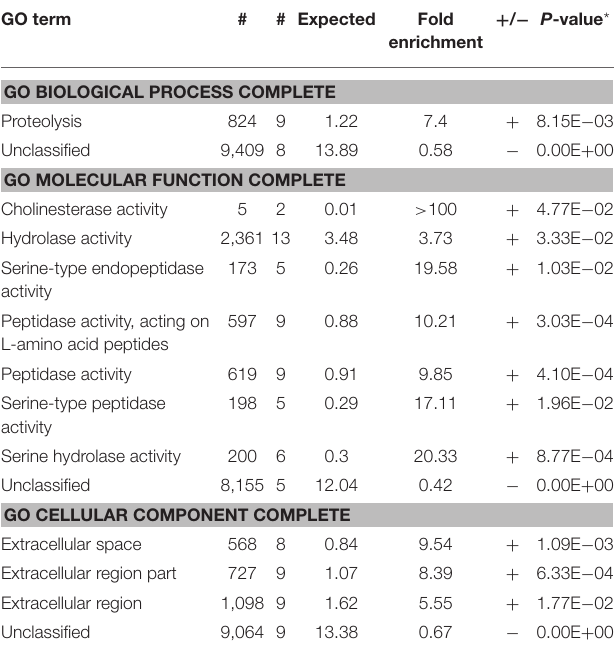
TABLE 1 | GO enriched by feeding transgenic diet through PANTHER overrepresentation